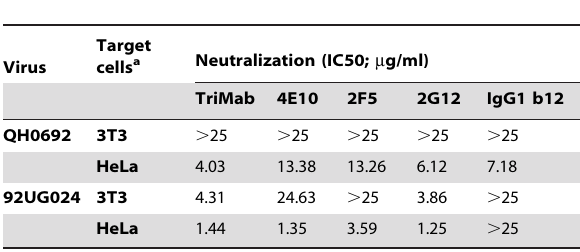
Table 6. Effect of target cell on neutralization in the fusion assay.